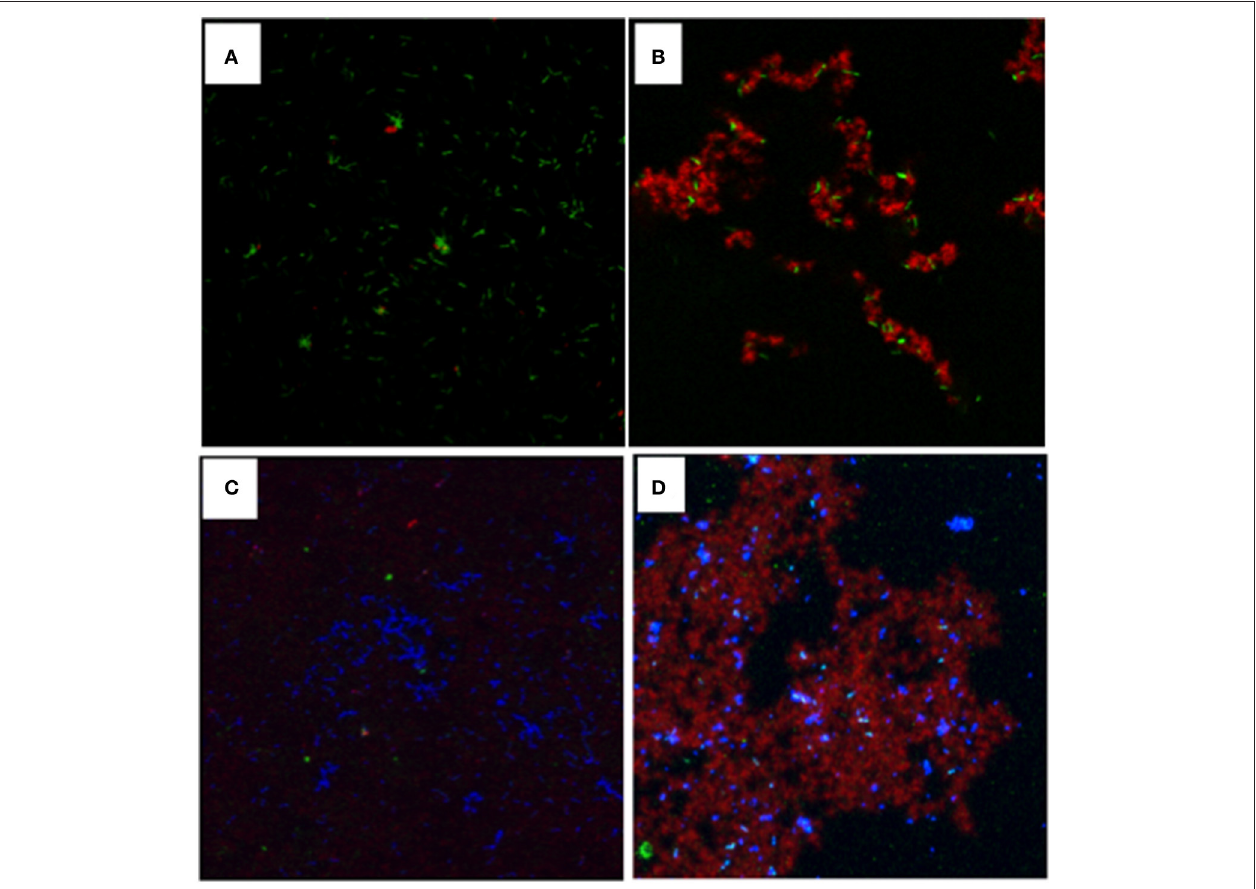
FIGURE 4 | Visualization of glucans synthesized in situ by GtfB adsorbed on L. casei and S. mutans binding to L. casei with and without glucans. For glucan visualization, L. casei was incubated with GtfB or buffer, and following washes, exposed to sucrose for 1h, and glucans were imaged using a confocal microscope. (A) L. casei cells (in green) with GtfB incubated in buffer alone; (B) L. casei with bound-GtfB incubated with sucrose showing rich glucans (in red) engulfed in green L. casei cells. For interactions, S. mutans were mixed proportionally with L. casei with and without GtfB glucan-coating. (C) S. mutans (in blue) incubated with green L. casei with no glucans on surface; and (D) S. mutans (in blue) incubated with L. casei coated with GtfB glucans (in red). Images were obtained using an upright Olympus confocal microscope with a 100x oil objective.